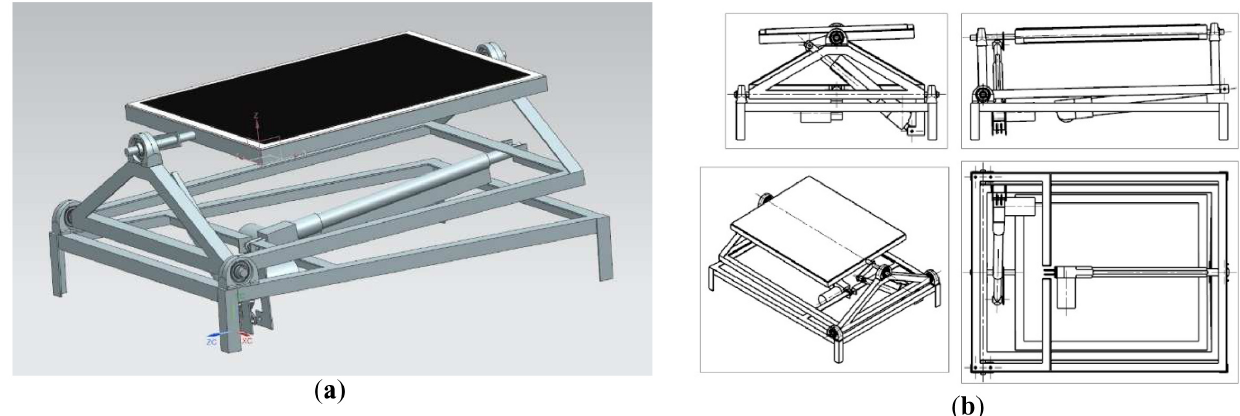
Figure 3. CAD model of a test bench for a prototype roof mounted solar panel equipped with a solar tracker. ( a ) Isometric view. ( b ) Spatial